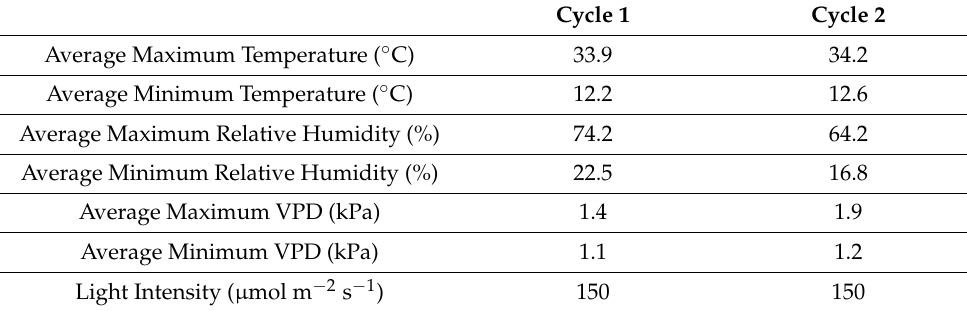
Table 1. Glasshouse environmental conditions during two drought